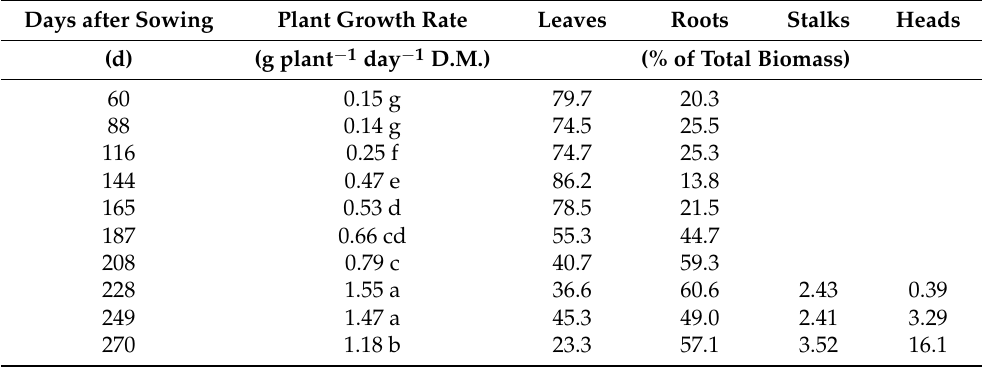
Figure 3. Biomass production per plant (g plant − 1 D.M.) variations during the whole growth cycle of wild cardoon. Table 1. Plant growth rate (g plant − 1 day − 1 D.M.) and biomass partitioning (% of total biomass) variations during the whole growth cycle of wild cardoon.